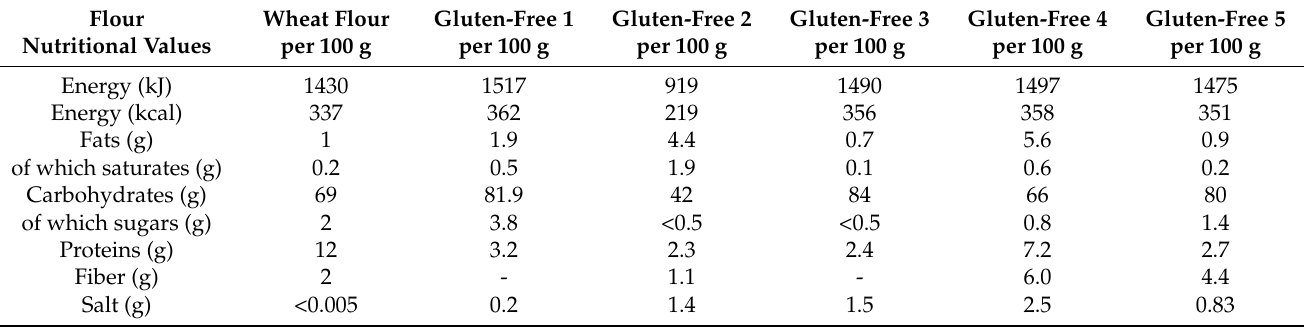
Table 1. Nutritional values of wheat flour and gluten-free bread baking mixtures. The values were obtained from the product packages or available on https://itesco.cz/ (accessed on 24 Jan 2022).